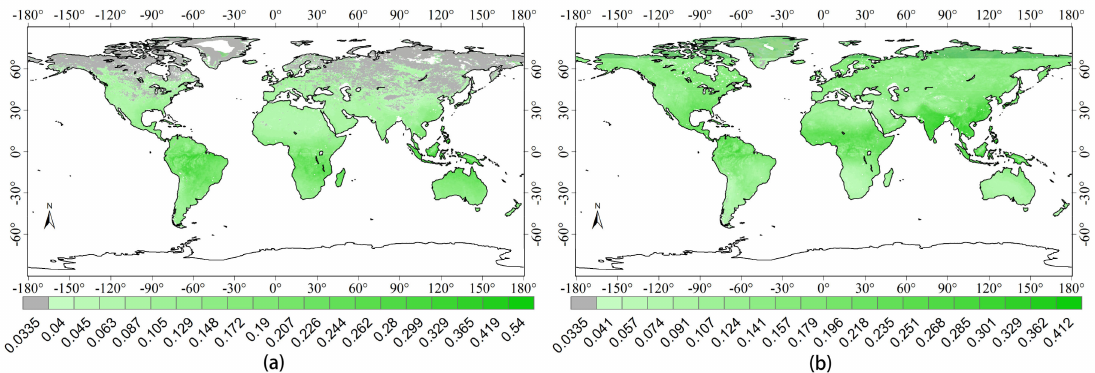
Figure 11. The difference between seasonal averaged MVI _ B ( X , Ku ) (atmosphere corrected MVI_B ) and MVI _ B ( X , Ku ) ∗ (original MVI_B ); ( a ) The difference between seasonal averaged MVI _ B ( X , Ku ) and MVI _ B ( X , Ku ) ∗ in the months of DJF; ( b ) the difference between seasonal averaged MVI _ B ( X , Ku ) and MVI _ B ( X , Ku ) ∗ in the months of